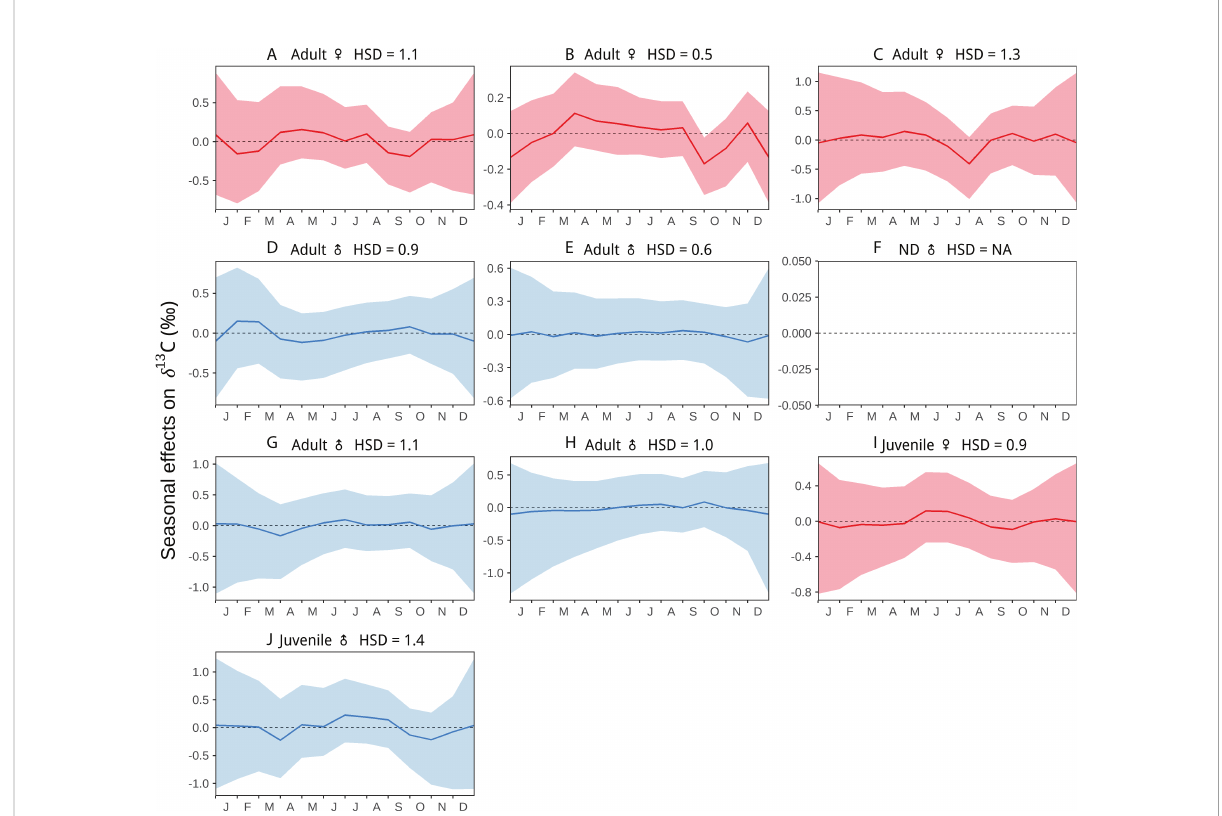
FIGURE 5 Seasonal random effects on Suess corrected d 13 C along nine individual blue whale baleen plates as a function of time. The hyper-standard deviation (HSD) of the random-effect likelihoods is reported for each whale. Colors represent females (red), and males (blue). Colored dots and lines are the medians of the random effects, and colored shaded areas are the 95%-credible intervals. Figure shows whales (A – J) . HSD could not be estimated for whale (F) given the lack of information on stranding date, so the temporal scale corresponds to the number of years re fl ected in the baleen